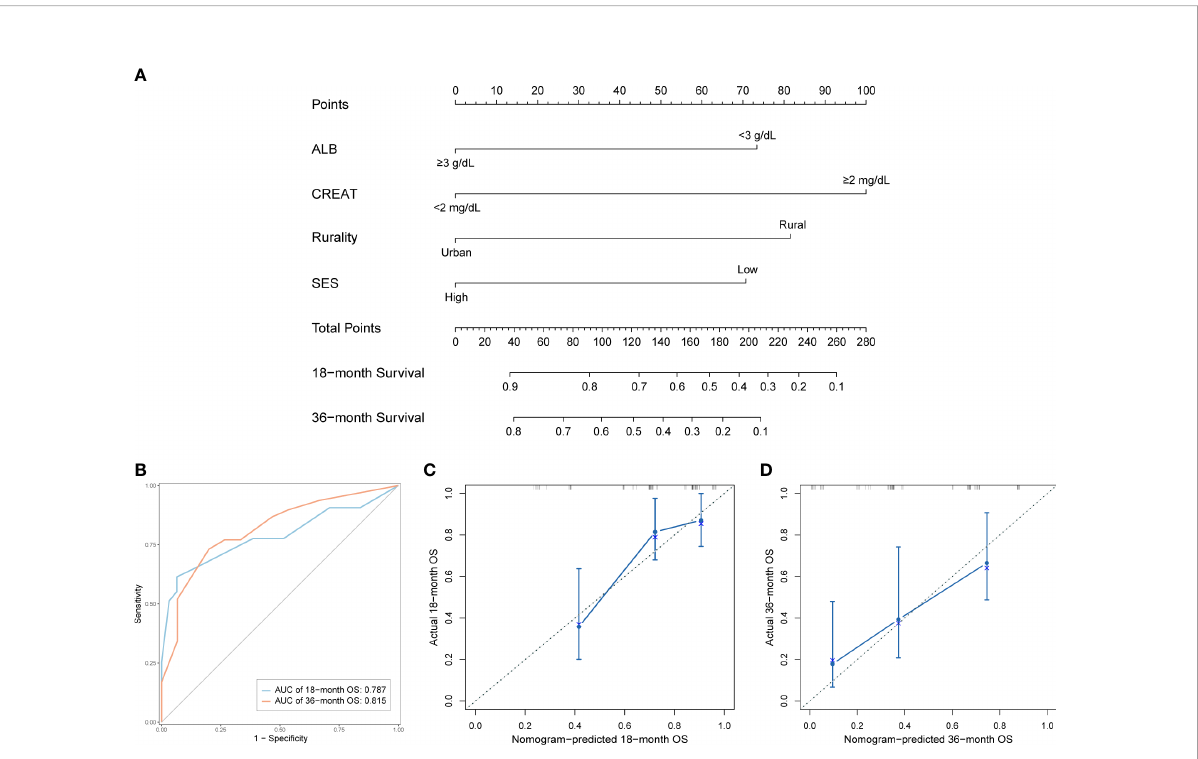
FIGURE 4 Development and validation of the prognostic nomogram in the training cohort. (A) Nomogram for predicting 18- and 36-month OS. (B) Time- dependent ROC curves and AUC values of the nomogram. (C) Calibration plot for predicting 18-month OS. (D) Calibration plot for predicting 36-month